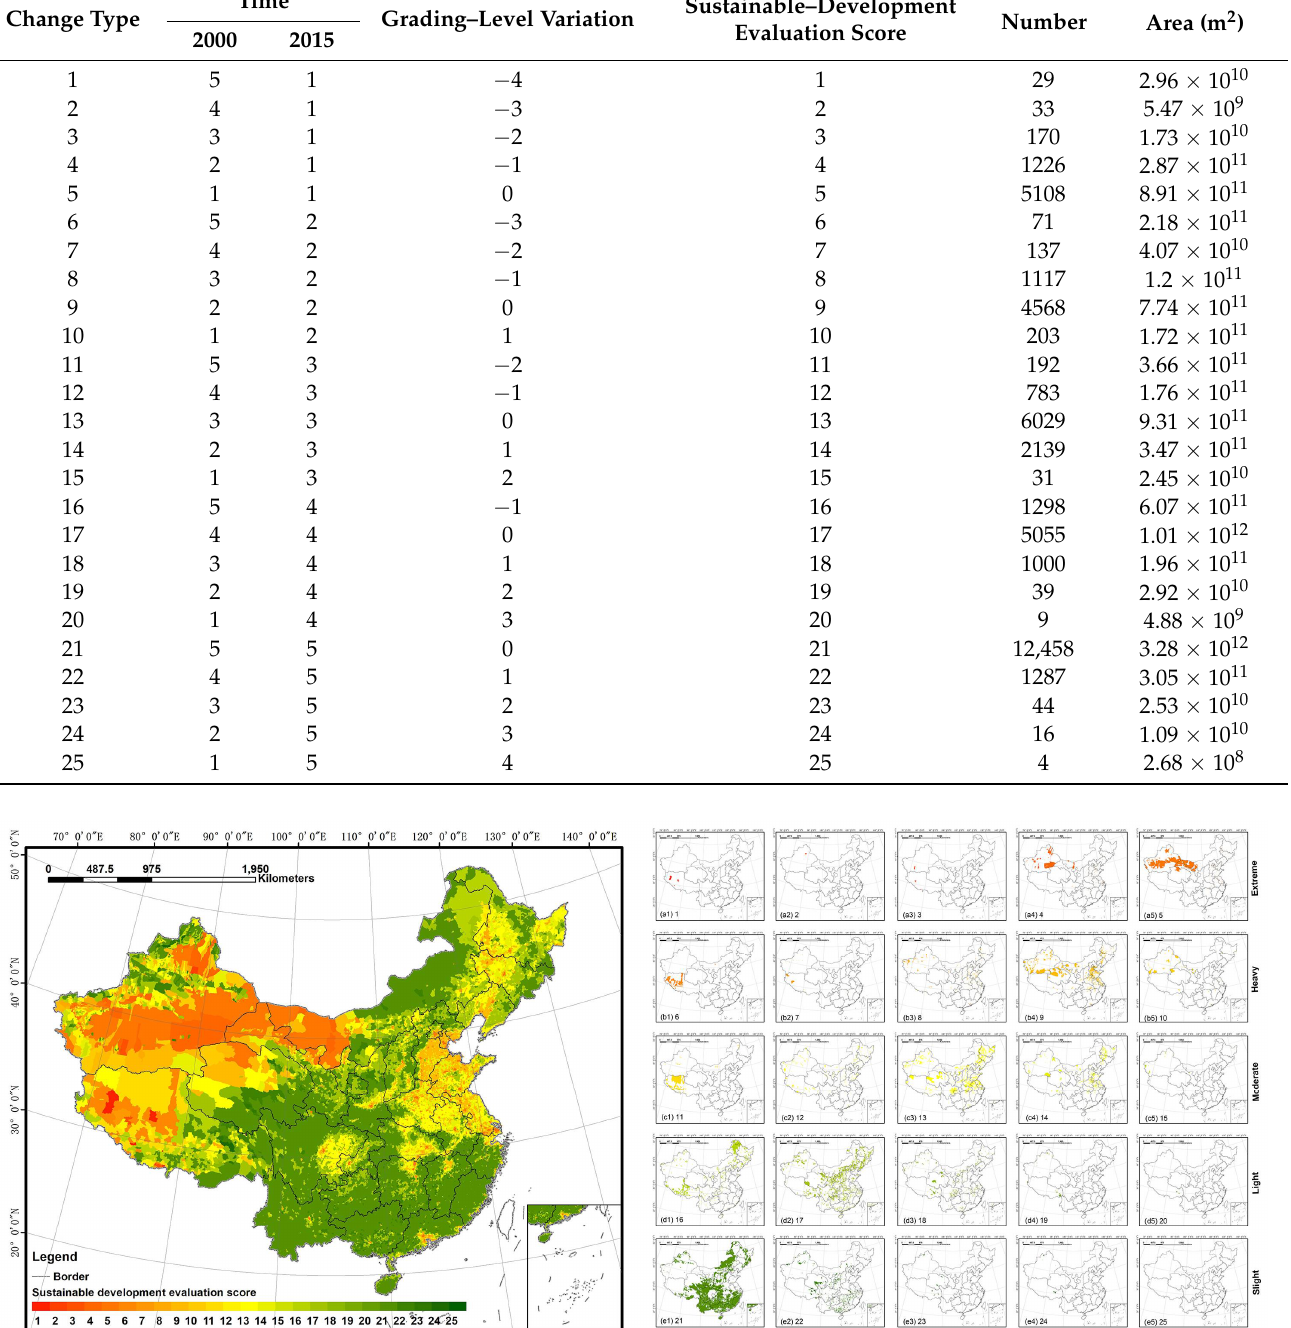
Table 8. Detailed information on the 25 types of variation and the sustainable–development evalua- tion score.